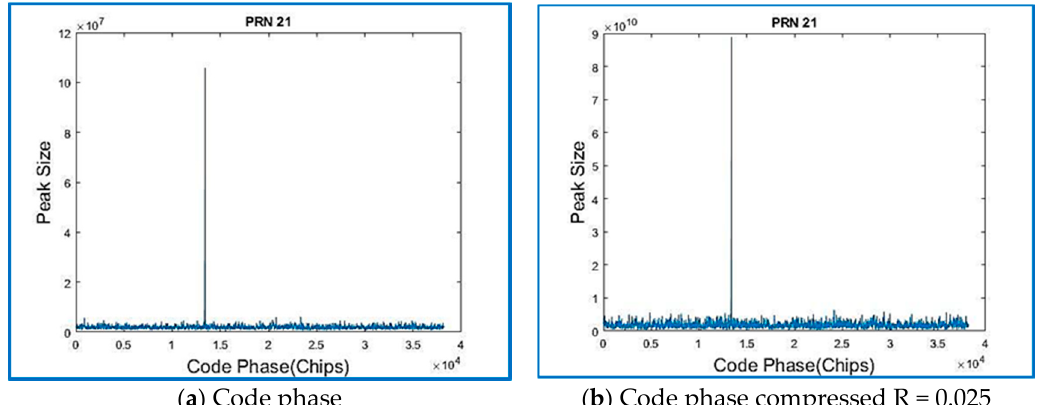
Figure 12. Recorded real signal from Dataset 1: ( a ) the code phase; and ( b ) the code phase of the GPS signal when the signal is compressed.